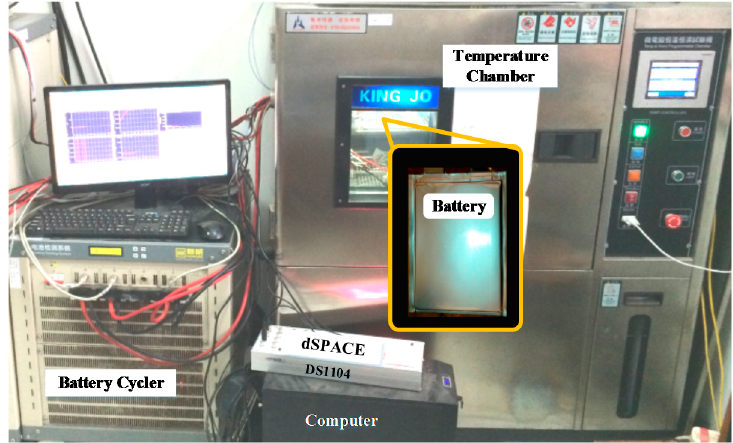
Figure 3. Experimental battery test work bench.